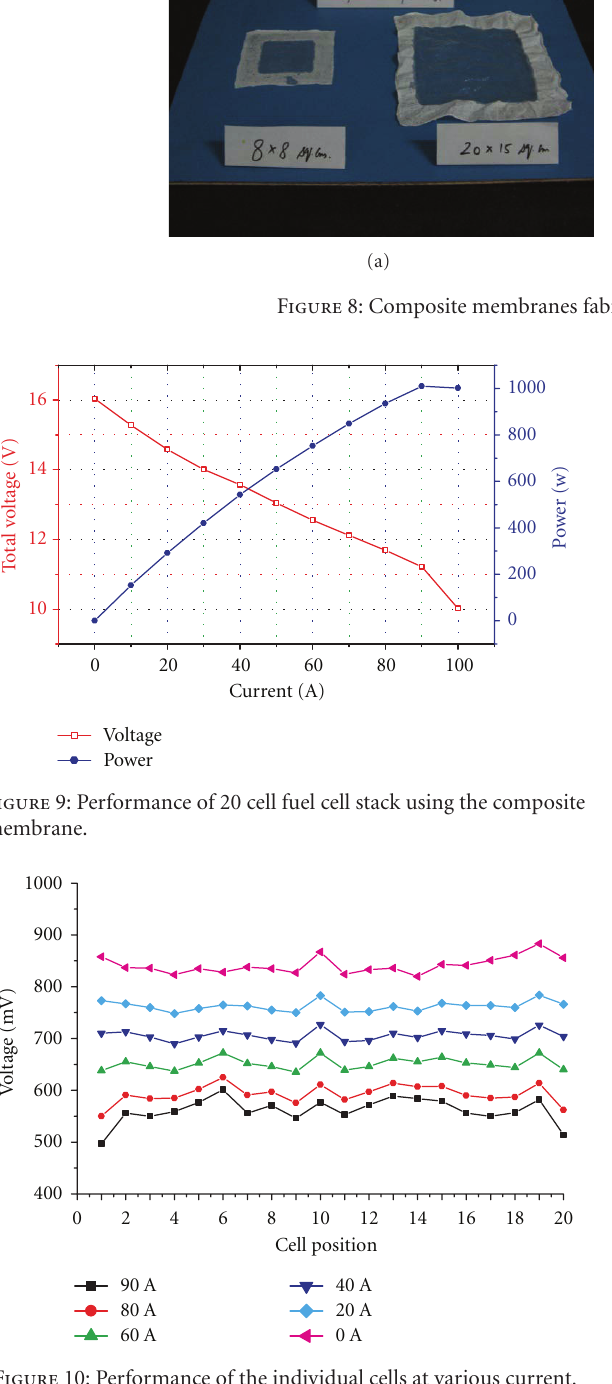
Figure 10: Performance of the individual cells at various current. various currents are shown in Figure 10. The results show that the voltage distribution is fairly uniform. The deviation from the mean voltage at current densities up to 200 mA/cm 2 was less than 6% and increasing to 12% at a current density of 250 mA/cm 2 . These results suggest that the